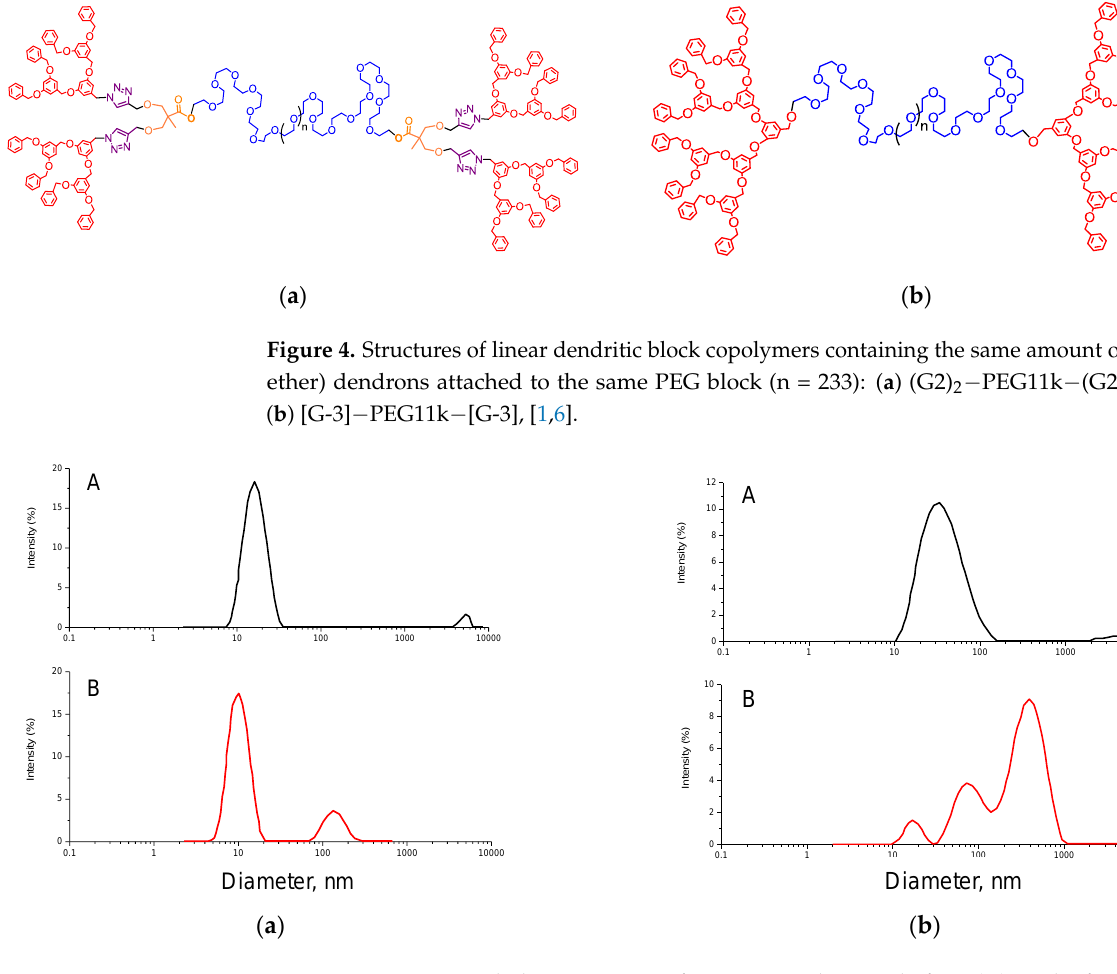
PdCl 2 (PhCN) 2 indicated a different mechanism of self-assembly, which was